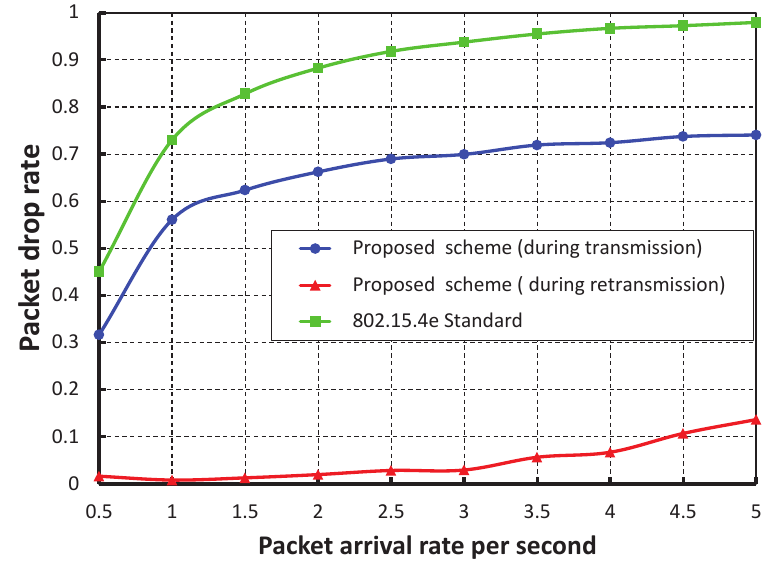
Figure 18. Comparison of the packet drop of our proposed scheme with the IEEE 802.15.4e standard. The energy consumption in joules/byte with different numbers of devices when one packet per second arrives at a device is shown in Figure